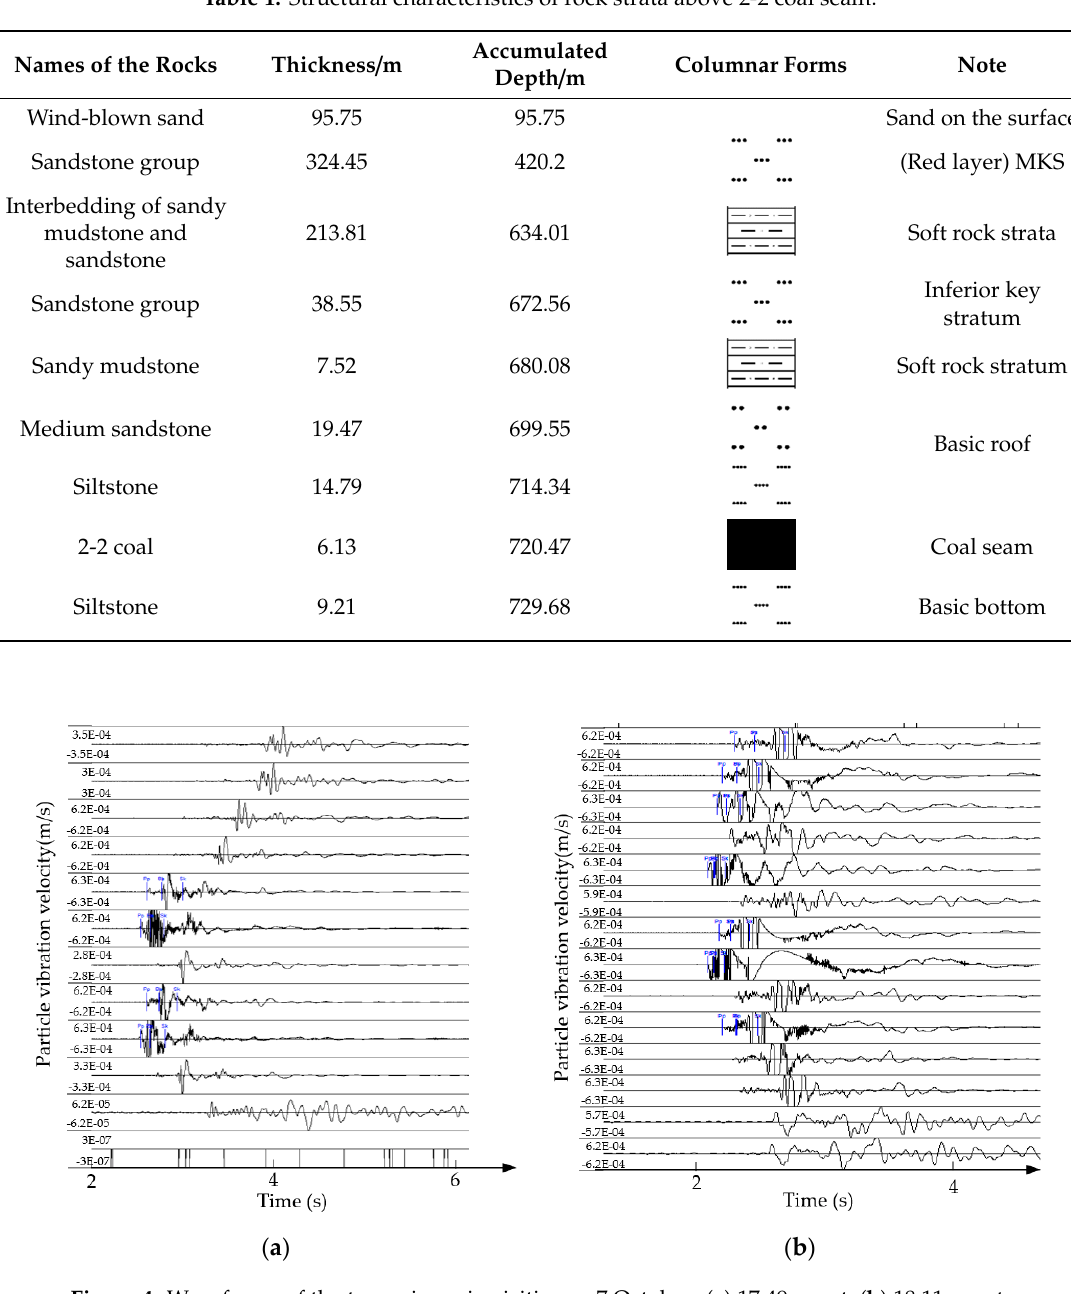
Figure 3. ICP and layout of working faces on both sides.